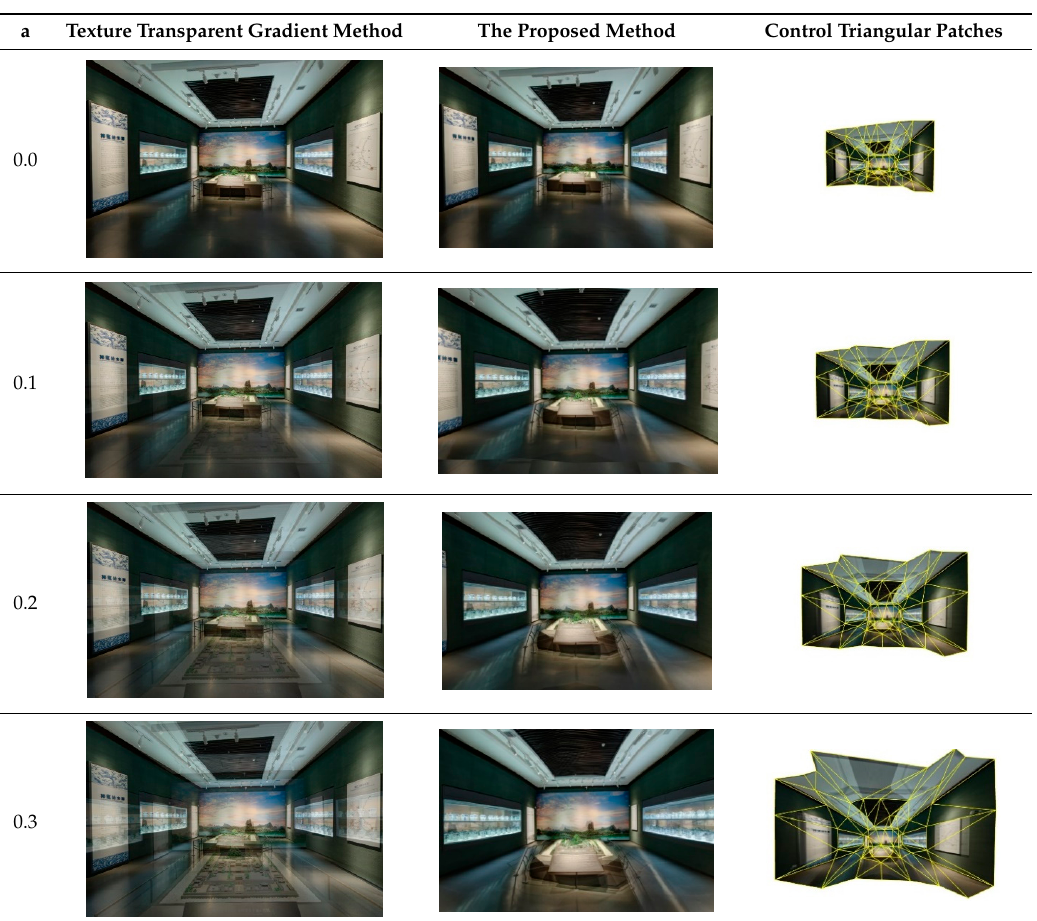
Table 2. Visualization performance of the proposed method compared with the texture transparent gradient method.